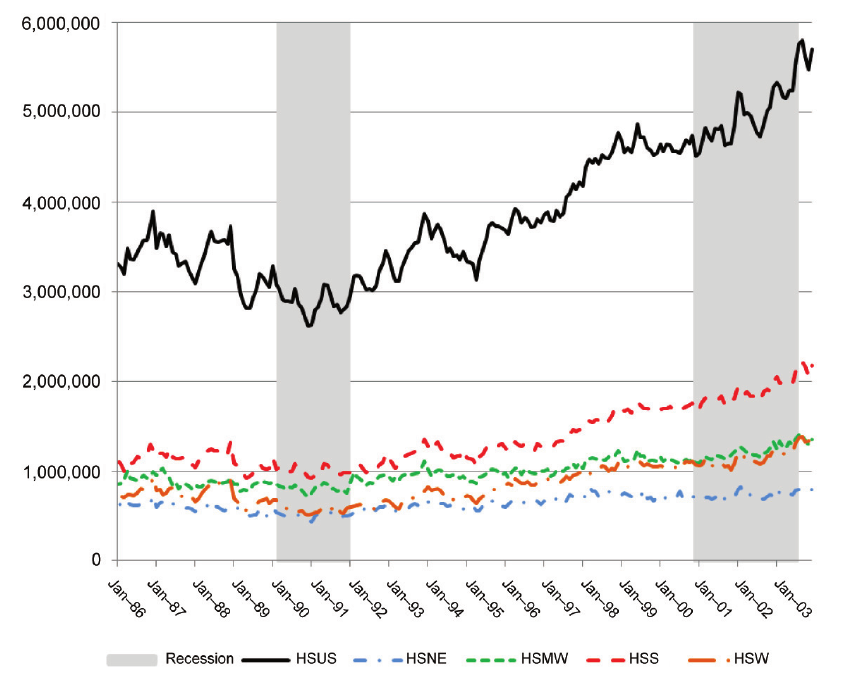
Figure 4. monthly housing